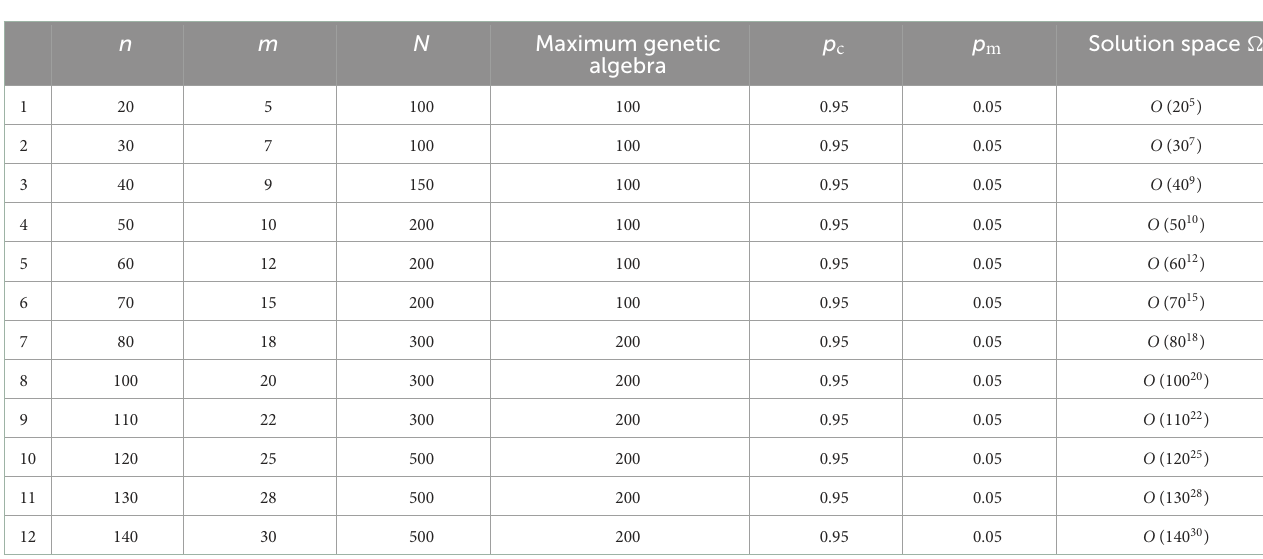
TABLE 7 Algorithm test